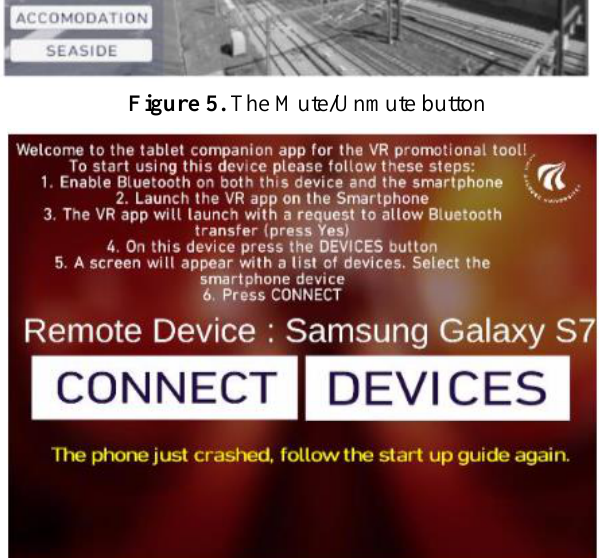
Figure 6. Application start-up